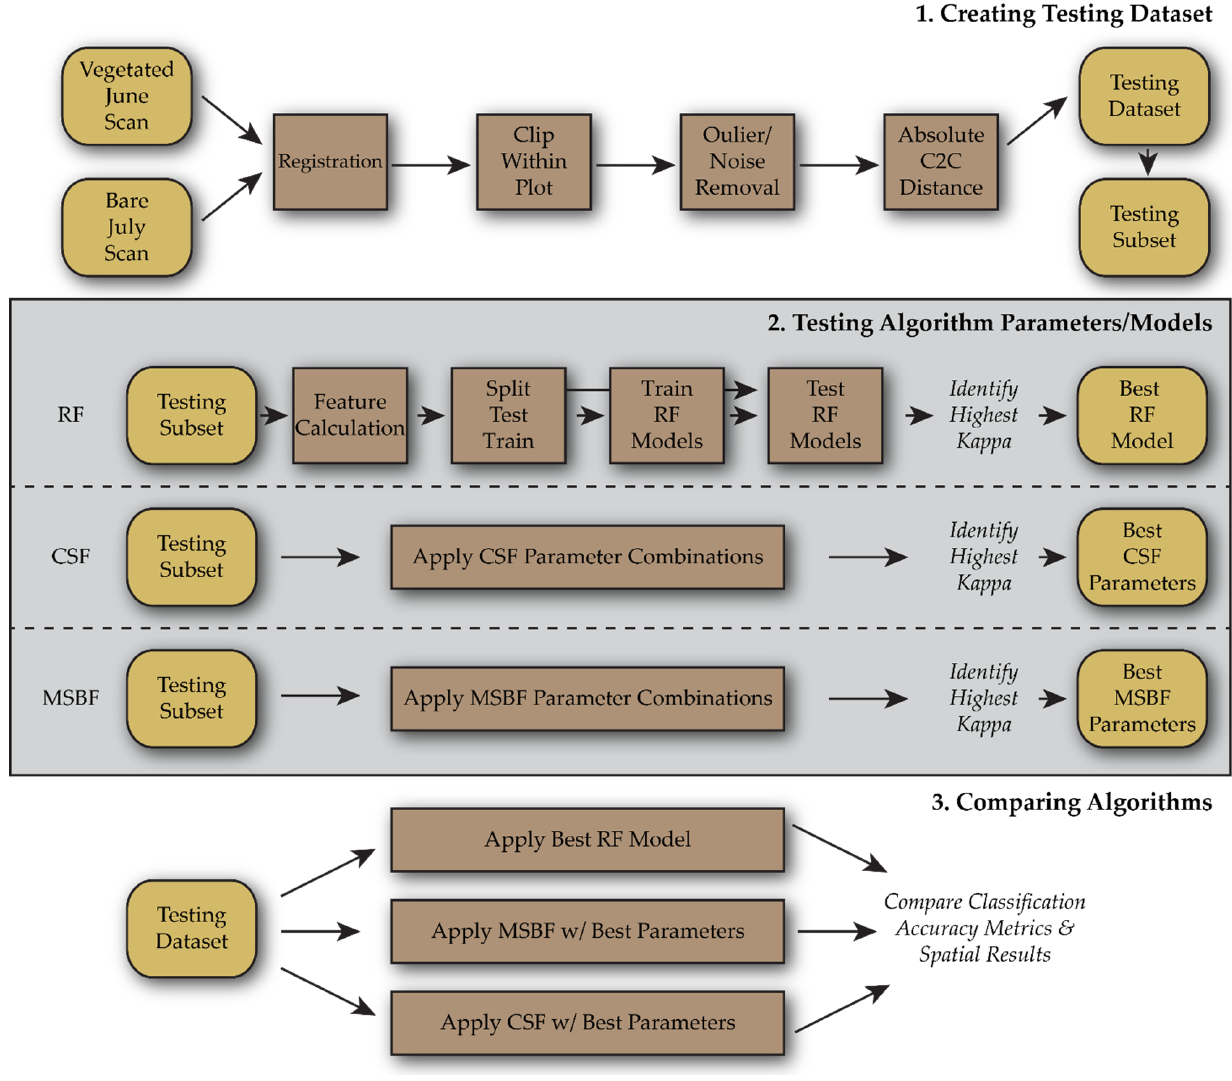
Figure 3. Flowchart of the research design.